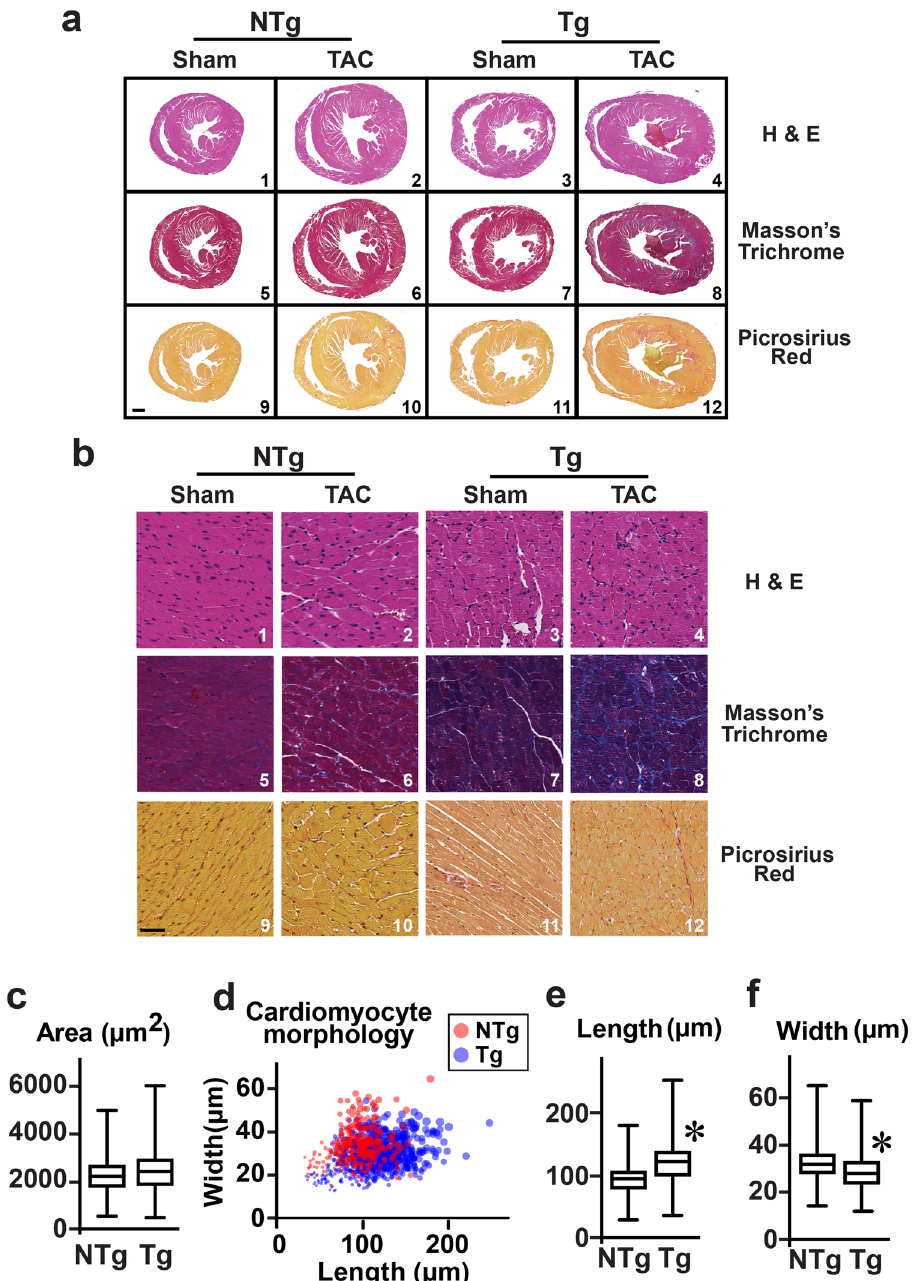
Figure 4. Immunohistochemistry of cardiac sections and adult cardiomyocyte morphology—Heart sections from NTg and Tg were stained with H & E, and collagen deposition was assessed using Masson’s Trichrome or Picrosirius red as indicators of fibrosis (n = 4). ( a ) Upper panel—lower magnification of the transverse sections. Scale bar 1000 µm. ( b ) Lower panel—higher magnification. Scale bar 200 µm (n = 4). Adult cardiomyocytes isolated from NTg and Tg were used for measuring cellular morphology using Image Pro 10 ( c ) cardiomyocyte area (µm 2 ), ( d ) cardiomyocytes morphology across measures of length and width (µm), ( e ) length and ( f ) width. * p < 0.001 vs. NTg (> 400